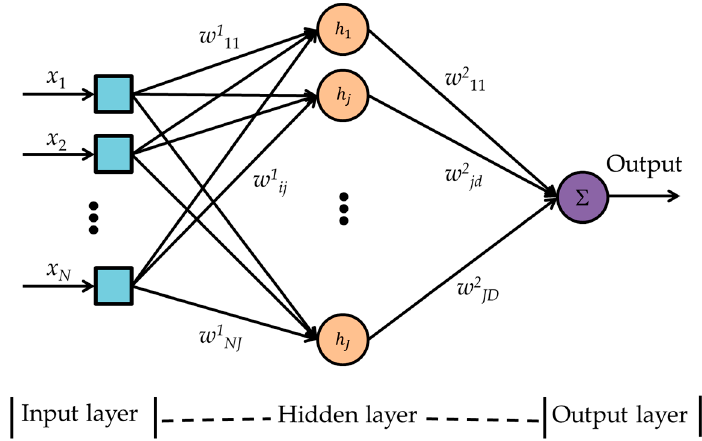
Figure 5. Multilayer perceptron neural network block diagram. i is the sensor index, j is the index for hidden layer neuron, and d is the index of output layer neuron.